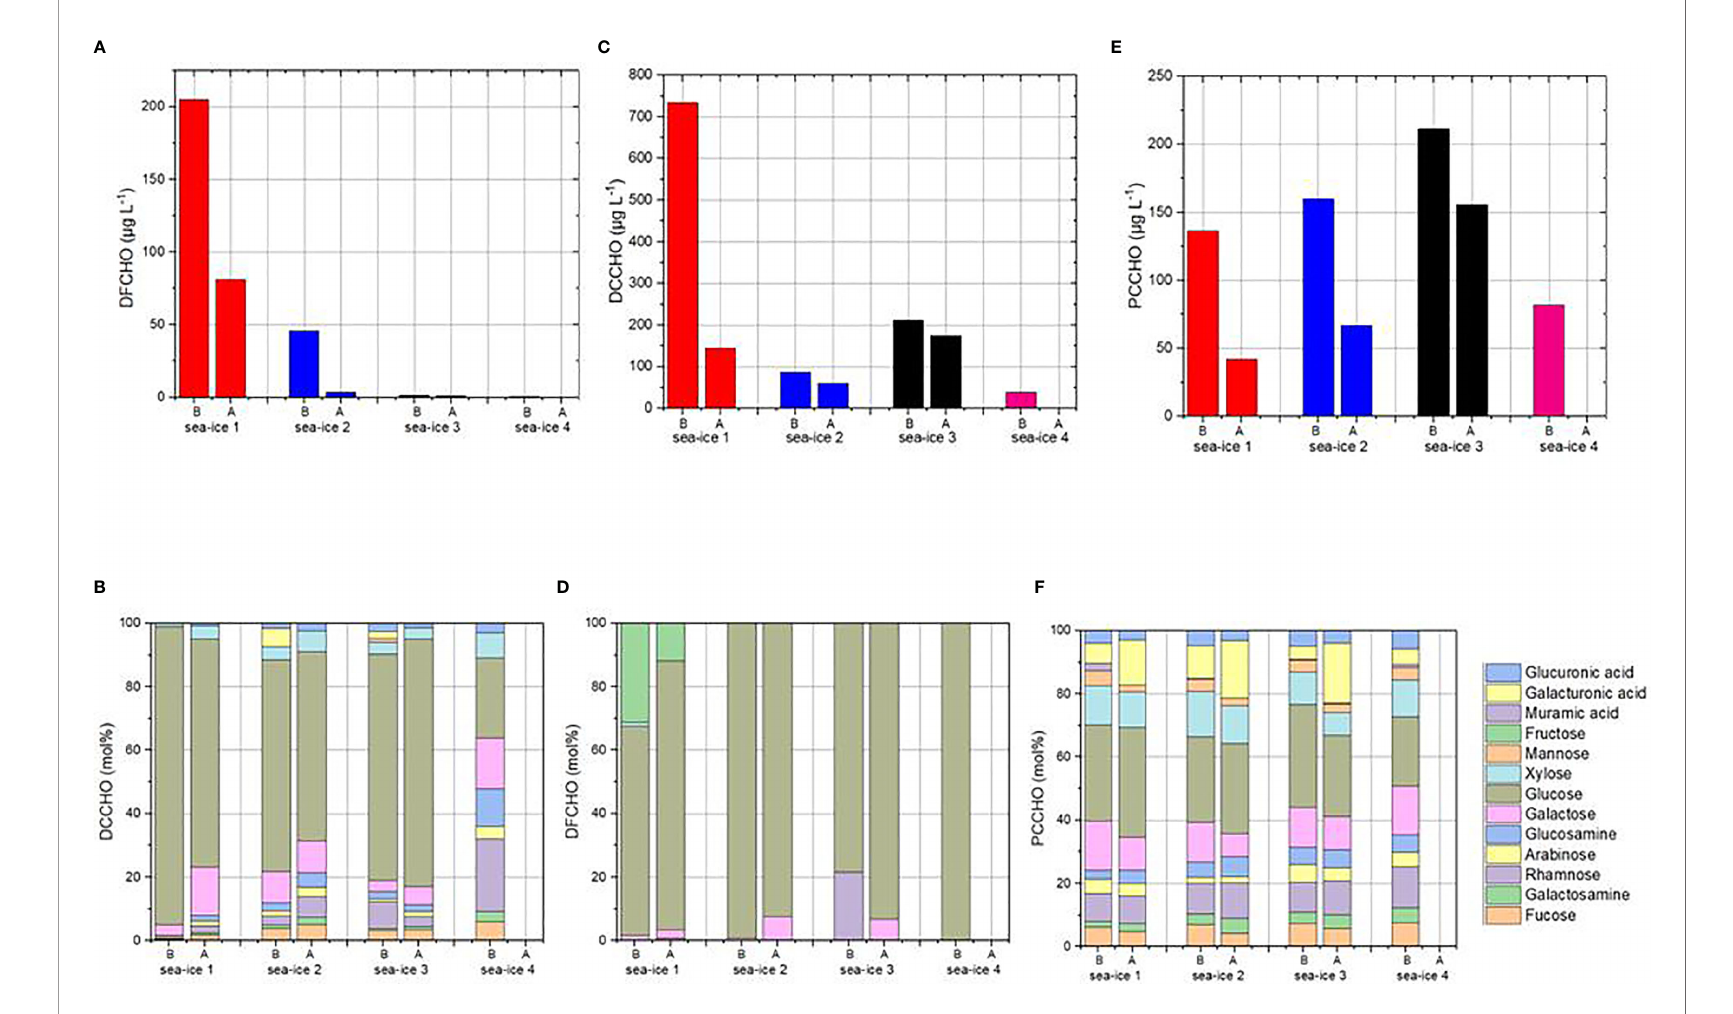
FIGURE 6 | DFCHO (6 A, B ), DCCHO (6 C, D ) and PCCHO (6 E, F ) for the four aerosol chamber experiments before and after